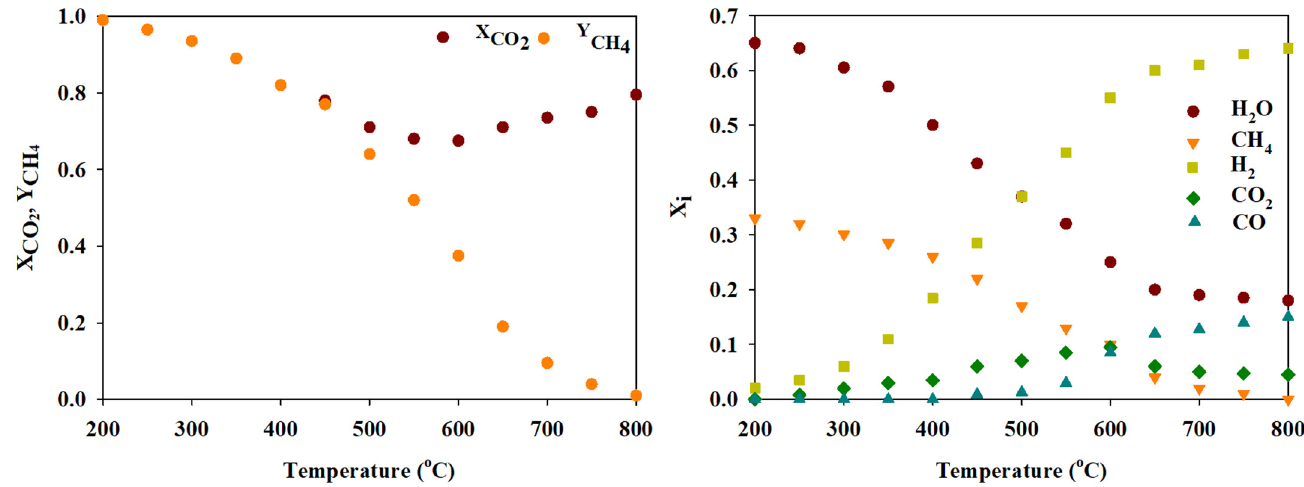
Figure 6. Equilibrium conversion rate ( left ) and the product fraction of CO 2 methanation at equilibrium ( right ), p = 1 bar, H 2 /CO 2 = 4.